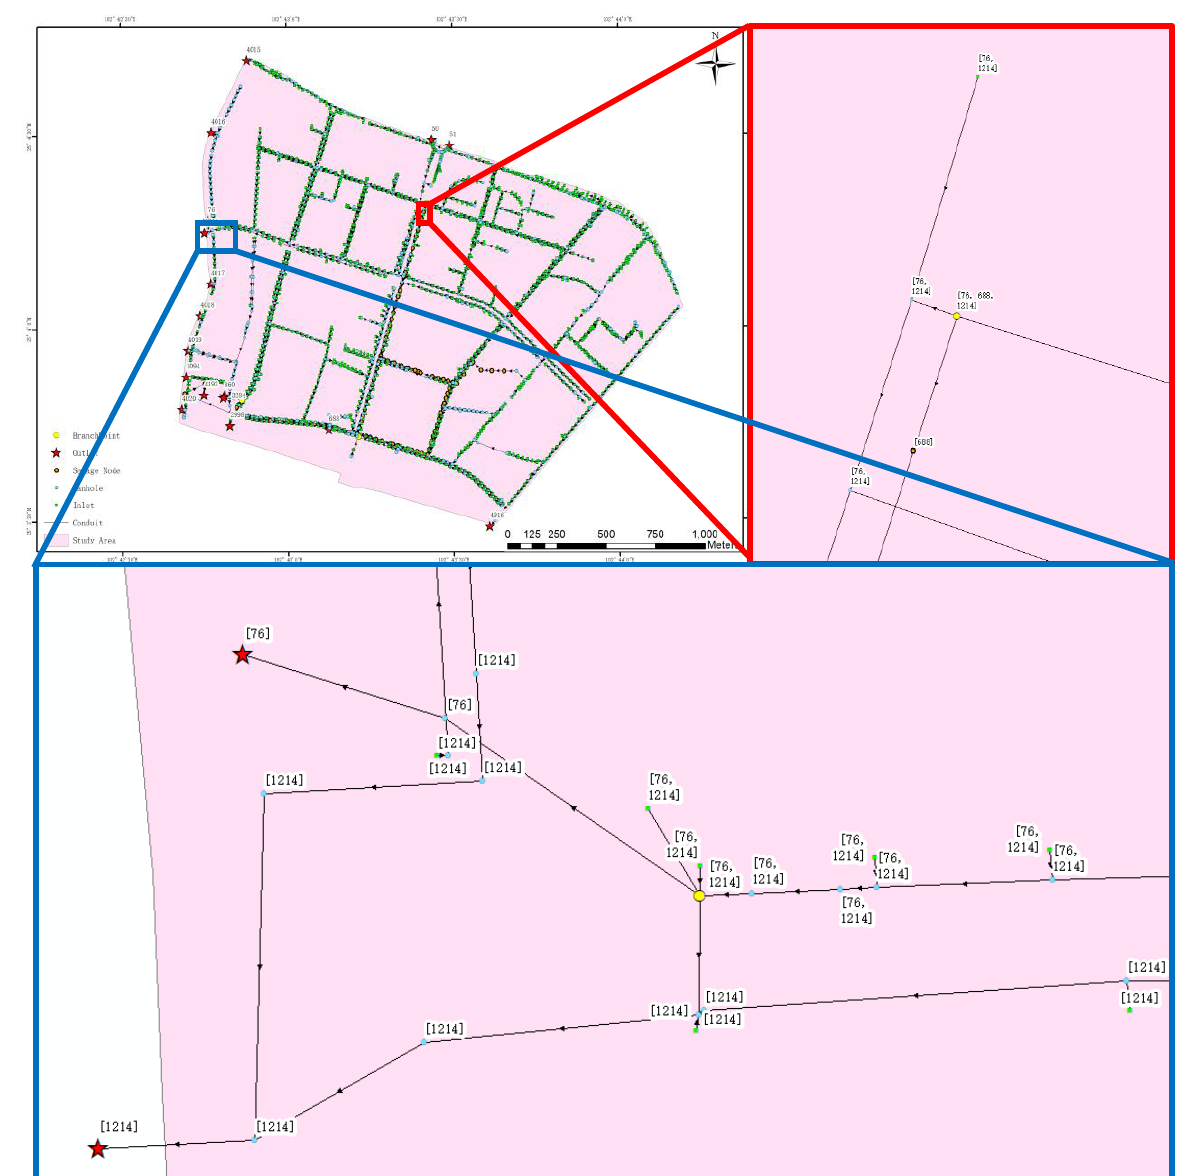
Figure 9. Some important branchpoints.